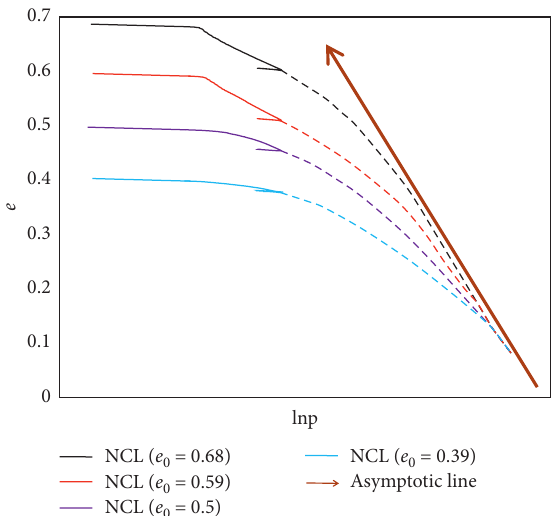
Figure 10: Isotropic compression lines of gravelly sand at initial void ratios of 0.68, 0.59, 0.5, and 0.39.